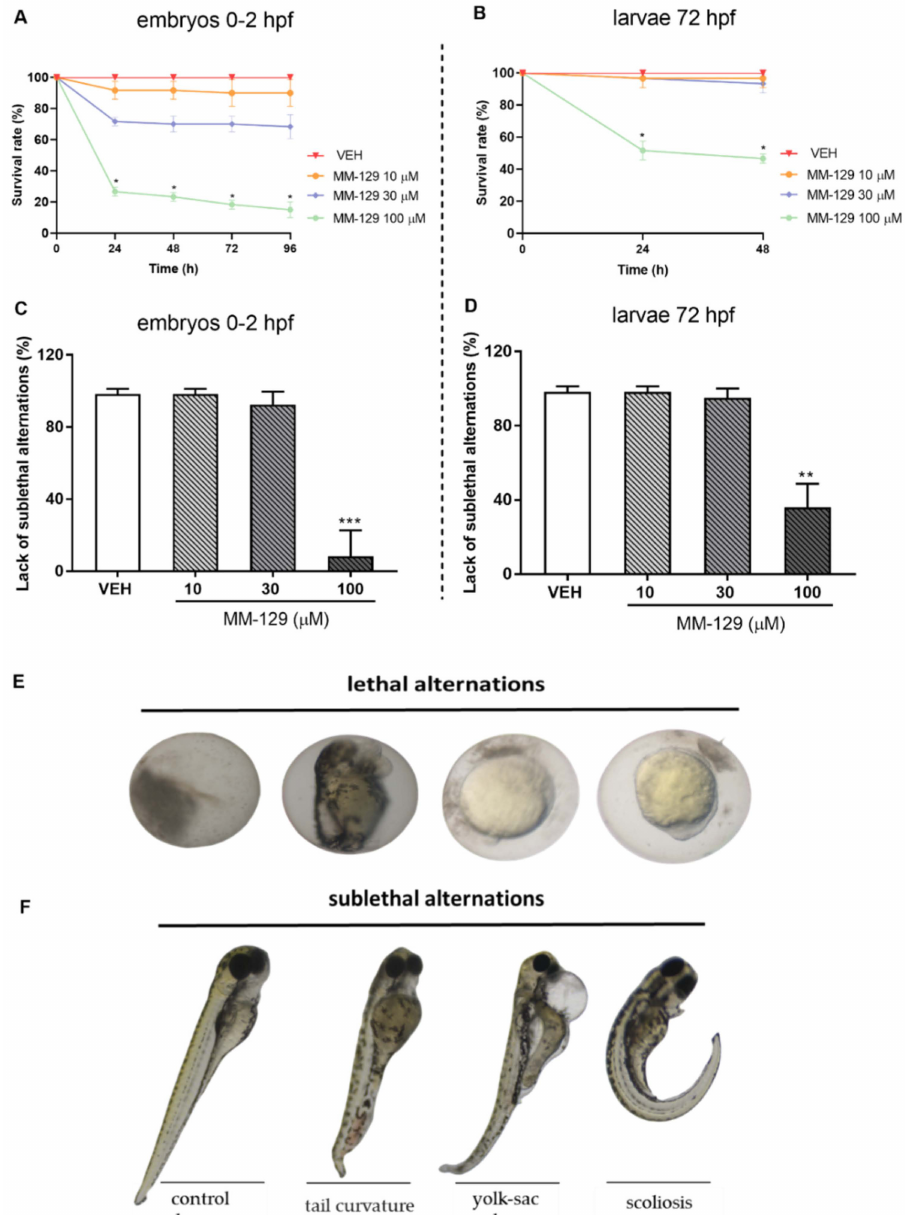
Figure 4. Survival rate ( A , B ) lack of sublethal alternations ( C , D ) for zebrafish embryos 0–2 hpf and larvae at 72 hpf exposed to MM-129 concentrations or vehicle (VEH) for 96 h. Lethal ( E ) and sublethal ( F ) alternations for zebrafish embryos 0-2 hpf exposed to MM-129 concentrations or vehicle (VEH) for 24 and 96 h. Sublethal alternations ( F ) for zebrafish embryos 0-2 hpf and larvae at 72 hpf exposed to MM-129 concentrations or vehicle (VEH) for 96 h. Data are shown as mean ± SD. * p < 0.05; ** p < 0.01; *** p < 0.001, vs. VEH within the group, n = 60 for each concentration. Abbreviations: MM-129—pyrazolo[4,3-e]tetrazolo[4,5-b][1,2,4]triazine sulfonamide;